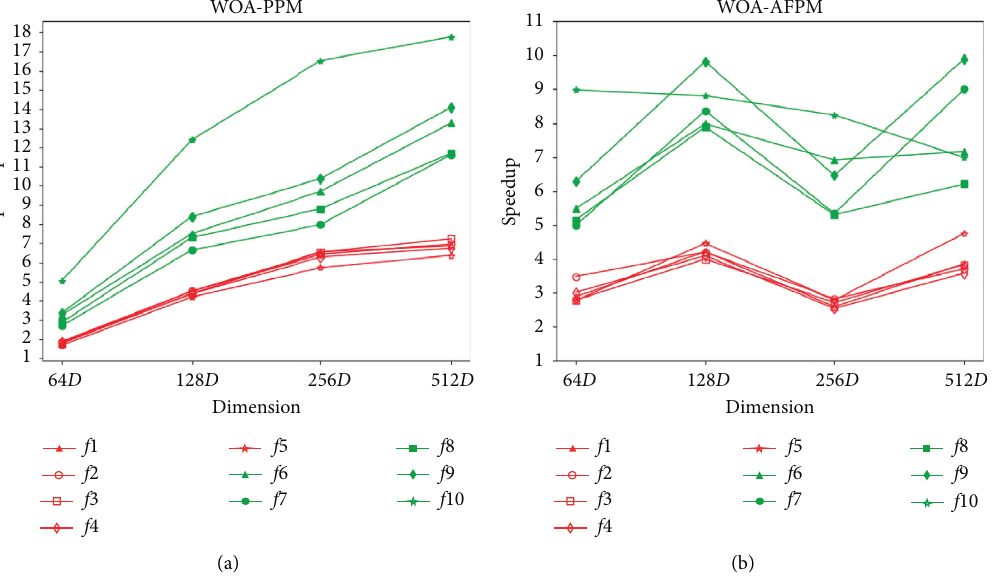
Figure 7: Speedup of PWOA-PPM and PWOA-AFPM w.r.t benchmark functions.